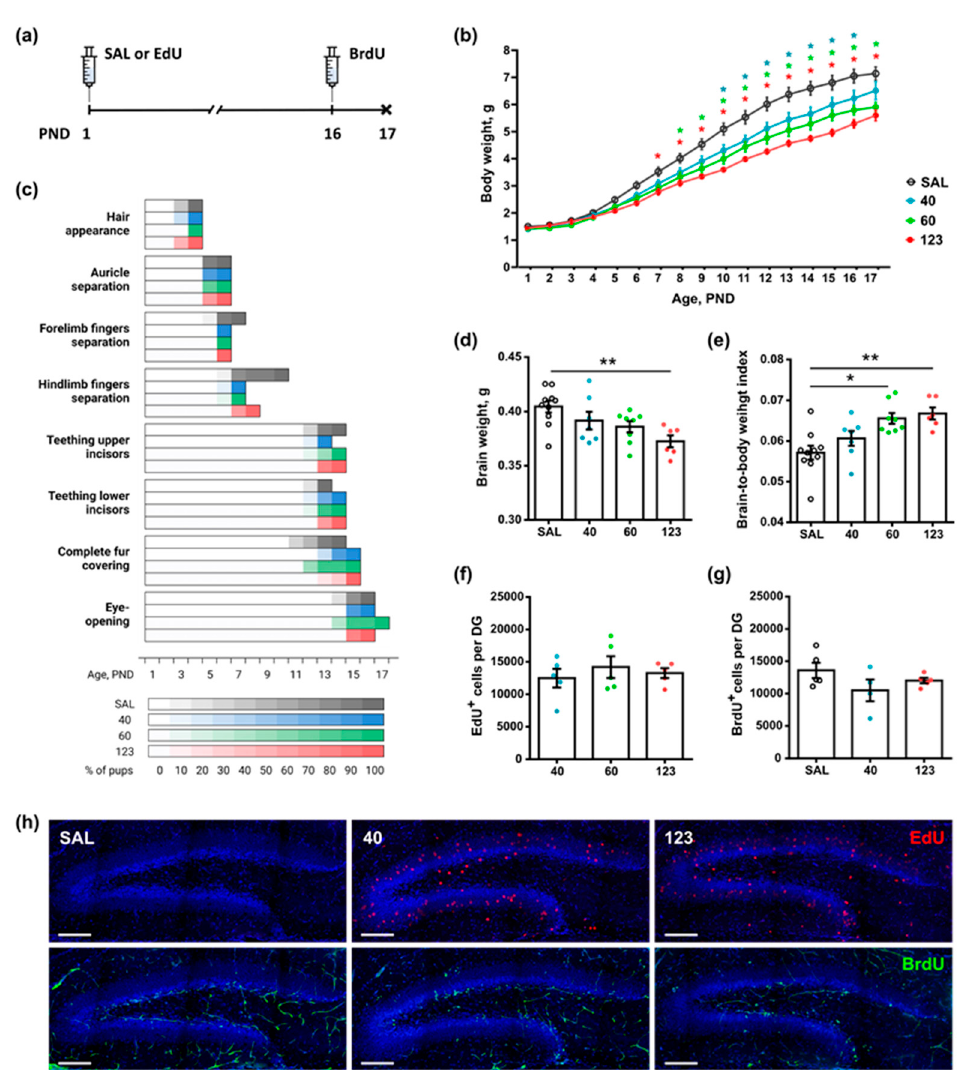
Figure 4. Effects of a single injection of EdU on somatic development and neurogenesis of newborn pups. ( a ) Scheme of injections. EdU at different doses (40, 60, or 123 mg/kg) or saline (SAL) was administered on PND1. BrdU (50 mg/kg) was injected on PND16, and pups were euthanized on PND17. ( b ) Weight change dynamics in control and EdU-injected pups. Two-way ANOVA, Tukey’s posthoc test, * p < 0.05. Differences between the SAL and EdU groups are shown. Blue, green, and red stars indicate p -values for the 40, 60, and 123 mg/kg groups, respectively. ( c ) Somatic development of control and EdU-injected pups. ( d ) Brain weight in PND17 pups. ( e ) Brain weight to whole bodyweight ratio in PND17 pups. ( f ) Number of EdU + cells in the DG in PND17 pups (16 days after single injection). ( g ) Number of BrdU + cells in the DG in PND17 pups (24 h after single injection). ( d – g ) One-way ANOVA, Sidak’s posthoc test, * p < 0.05, and ** p < 0.01. ( h ) Representative images of EdU- and BrdU-labeled cells; the scale bar is 100 µm.